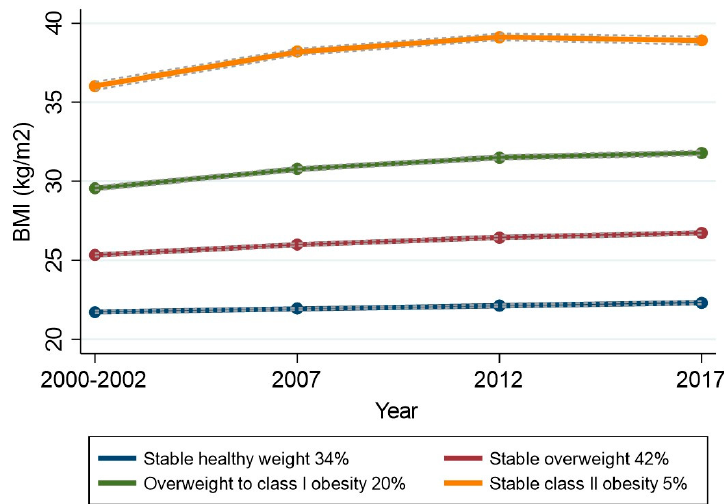
Figure 1. Body mass index (BMI) trajectory groups and their prevalence (%), identified by group-based trajectory modeling (group means and fitted lines with 95% confidence intervals).